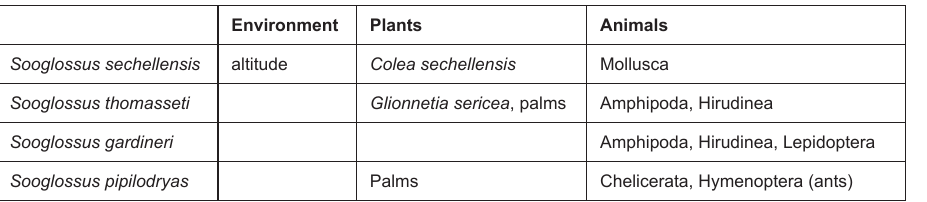
Table 1. Significant correlates of frog diversity (from Gerlach